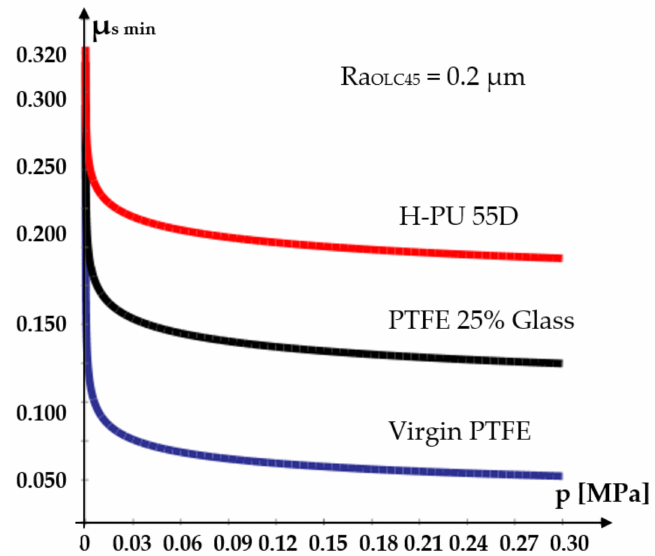
Figure 7. Dependency of the minimum static friction coefficient on contact pressure and seal